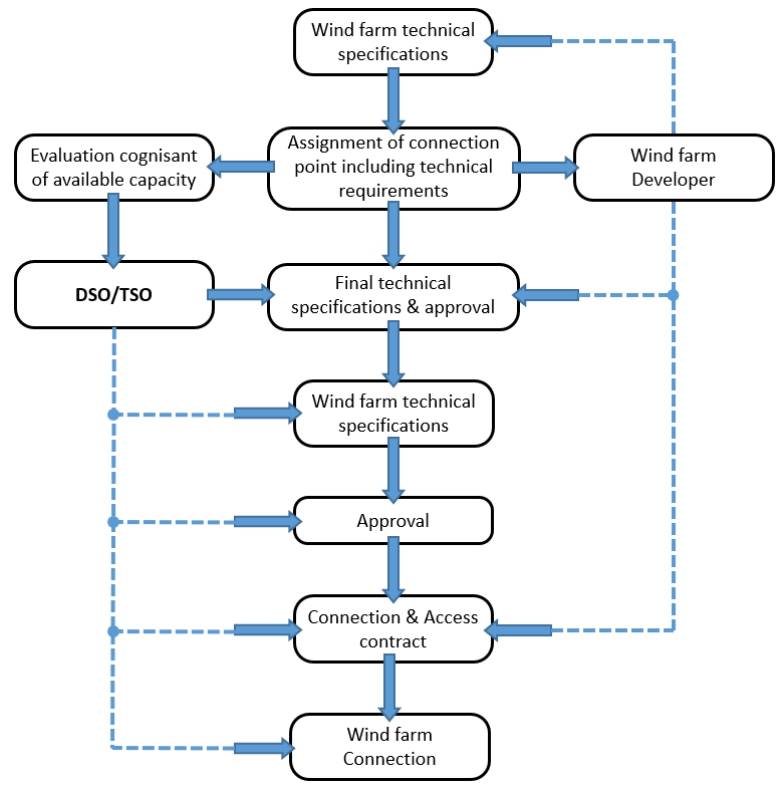
Figure 9. General connection procedure for wind power plants